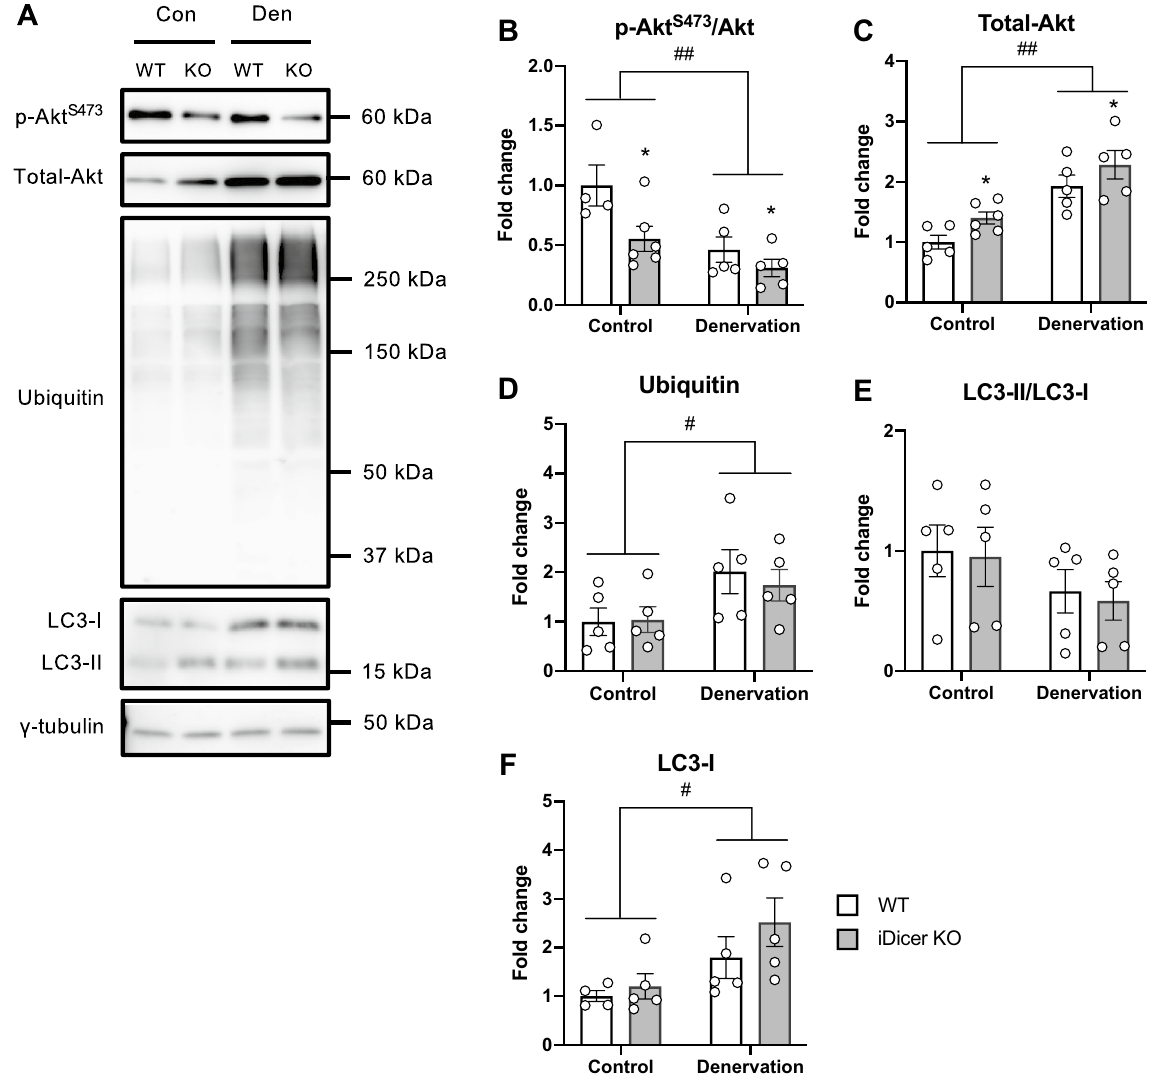
Figure 6. Protein expressions related to protein synthesis and degradation pathway in the iDicer knockout mice following denervation. ( A ) Representative blotting images for phosphorylated-Akt S473 , total-Akt, Ubiquitinated- proteins, LC3-I/II and γ-tubulin (n = 4–6). ( B ) The ratio of the phosphorylated-Akt S473 /total-Akt in the plantaris muscle from iDicer KO mice were lower than those from WT mice (Genotype, P < 0.05). Their levels in the plantaris muscles of WT and iDicer KO mice were decreased after 2 weeks of denervation